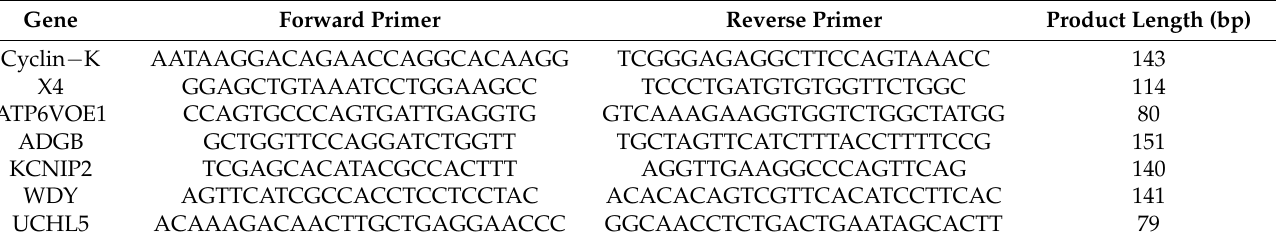
Table 1. The primer sequence of RT −